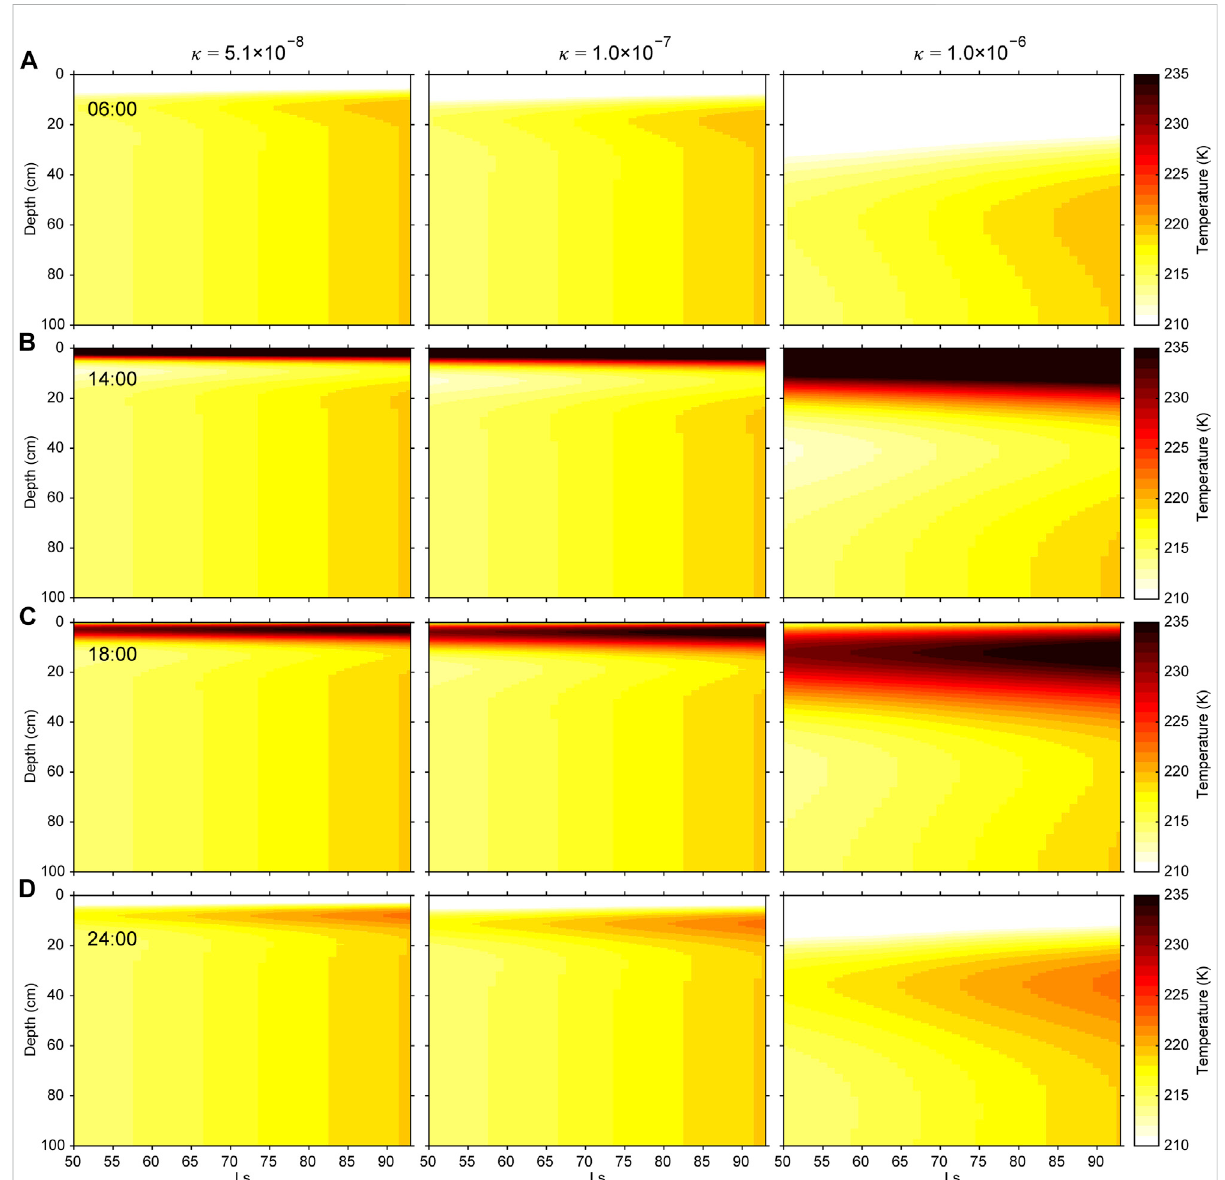
FIGURE 6 Temperature distributionin the top 100 cm subsurface under theZhurong landing site in its Sols 11 – 107 with Ls of 50 – 93. (A) 06:00; (B) 14:00; (C) 18:00; (D) 24:00. The left, middle, and right columns are based on the thermal diffusivity of 5.1 × 10 − 8 (InSight measured), 1 × 10 − 7 (water), and 1 × 10 − 6 (ice or sandstone),